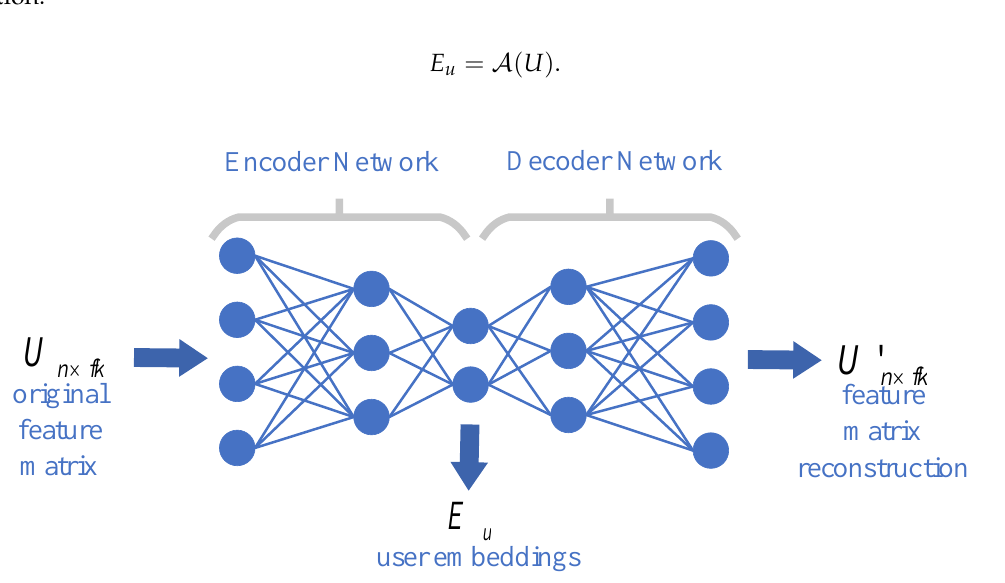
Figure 4. An illustration of the user embedding network, which is consist of an autoencoder. The example in this figure is a 5-layered autoencoder, with an 3-layered encoder and a 3-layered